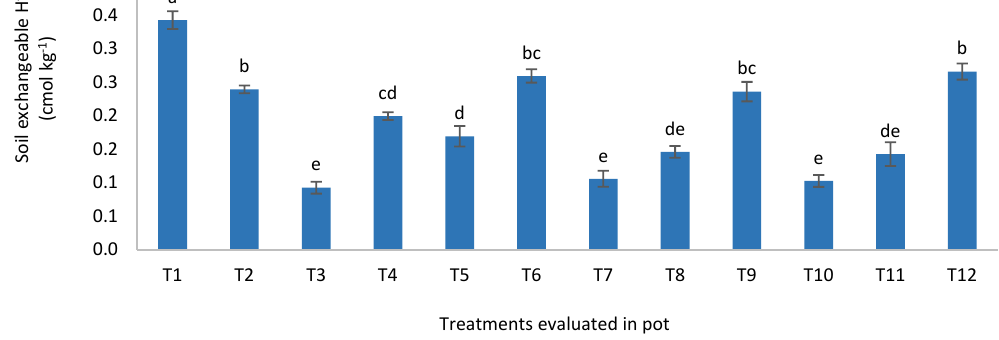
Figure 13. Effects of treatments on soil exchangeable Al 3+ . Different letters indicate significant difference between means using Tukey’s HSD (Honestly Significant Difference) test at p ≤ 0.05. The error bars are the ± standard error of triplicates.